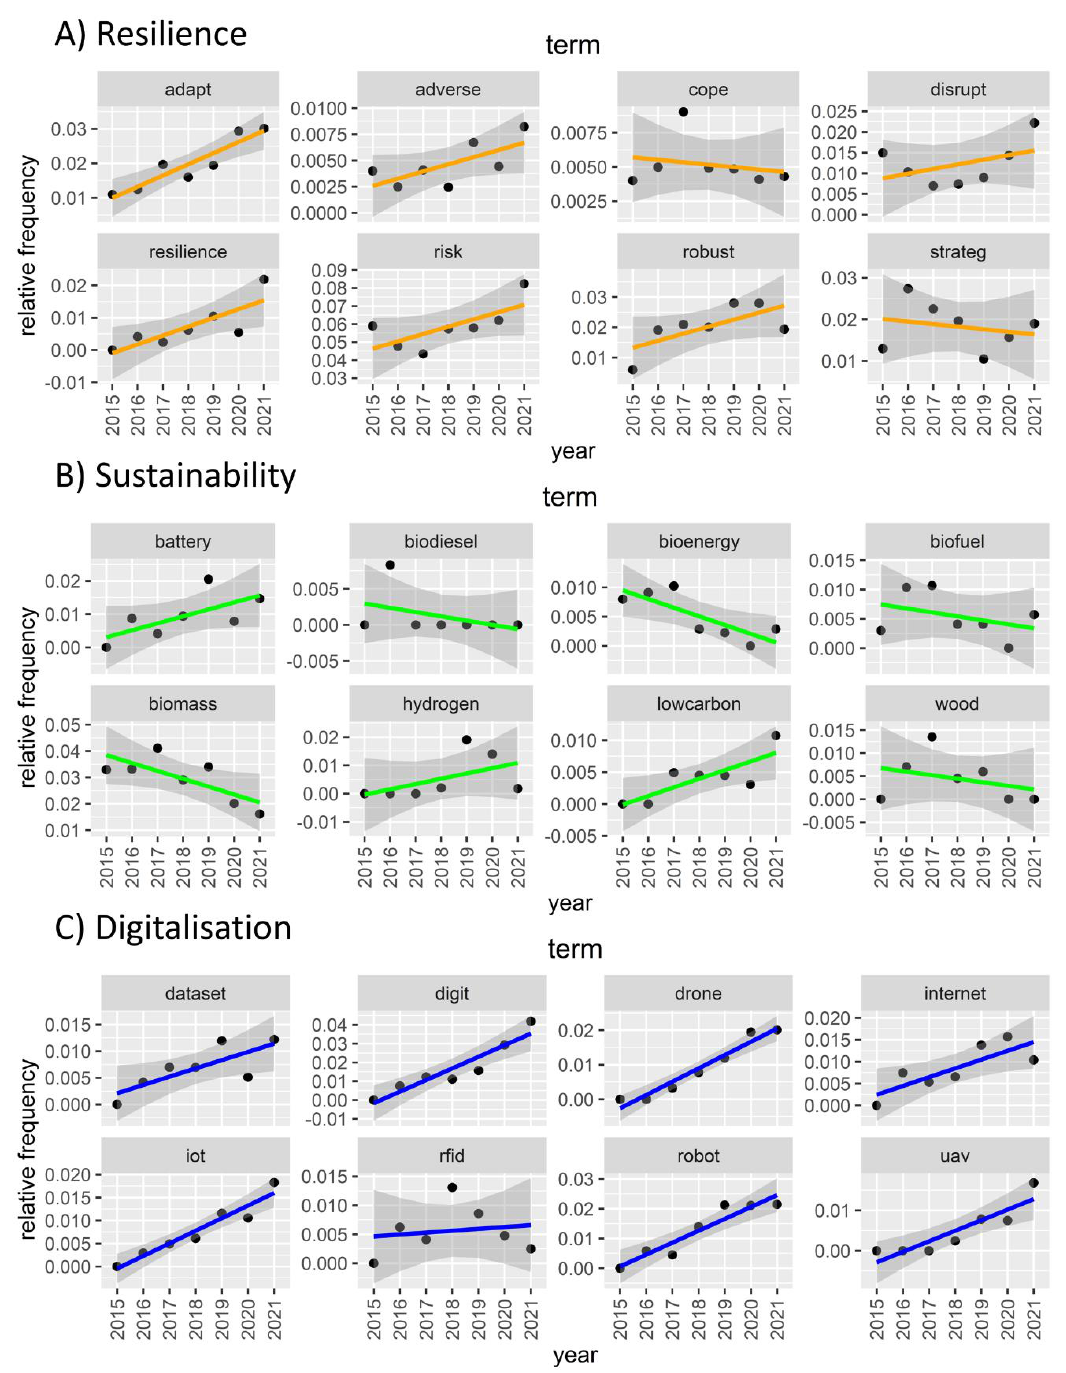
Figure 4. Time-based analysis of terms representing ( A ) resilience keywords (orange trend line), ( B ) sustainability keywords (green trend line), and ( C ) digitalization keywords (blue trend line).